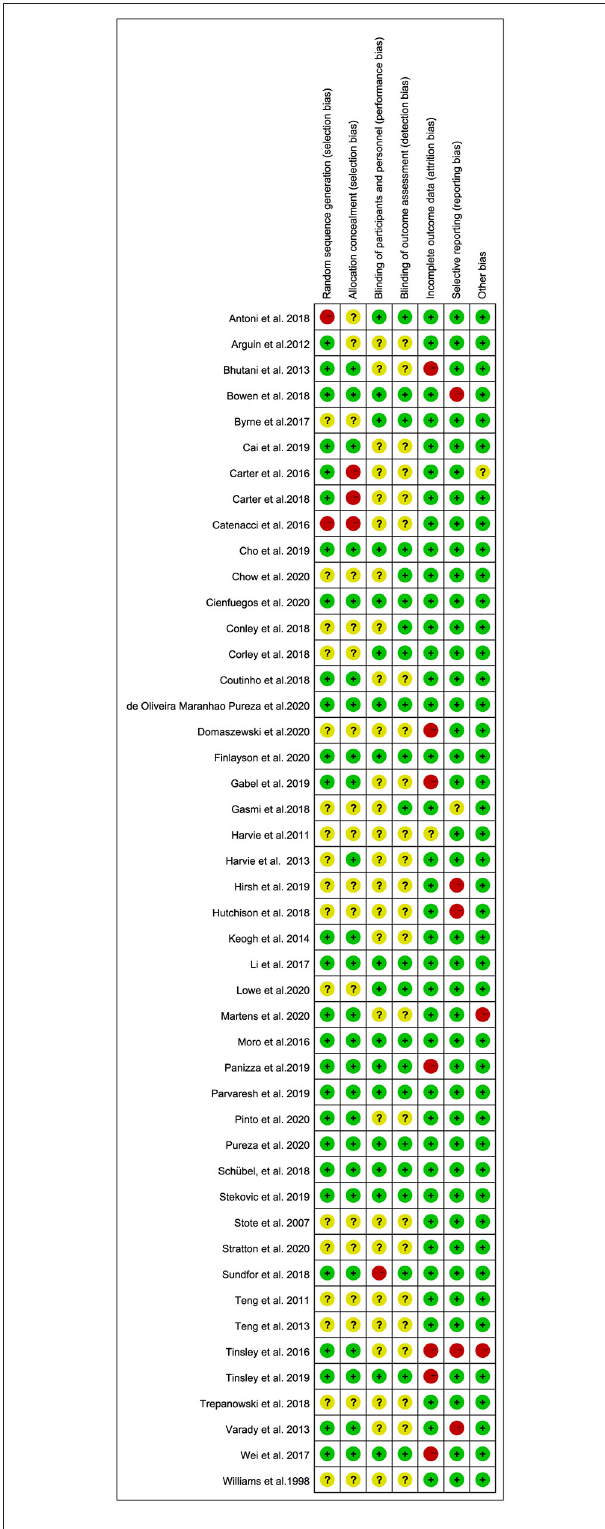
FIGURE 2 | Risk-of-bias assessment of the studies included in the